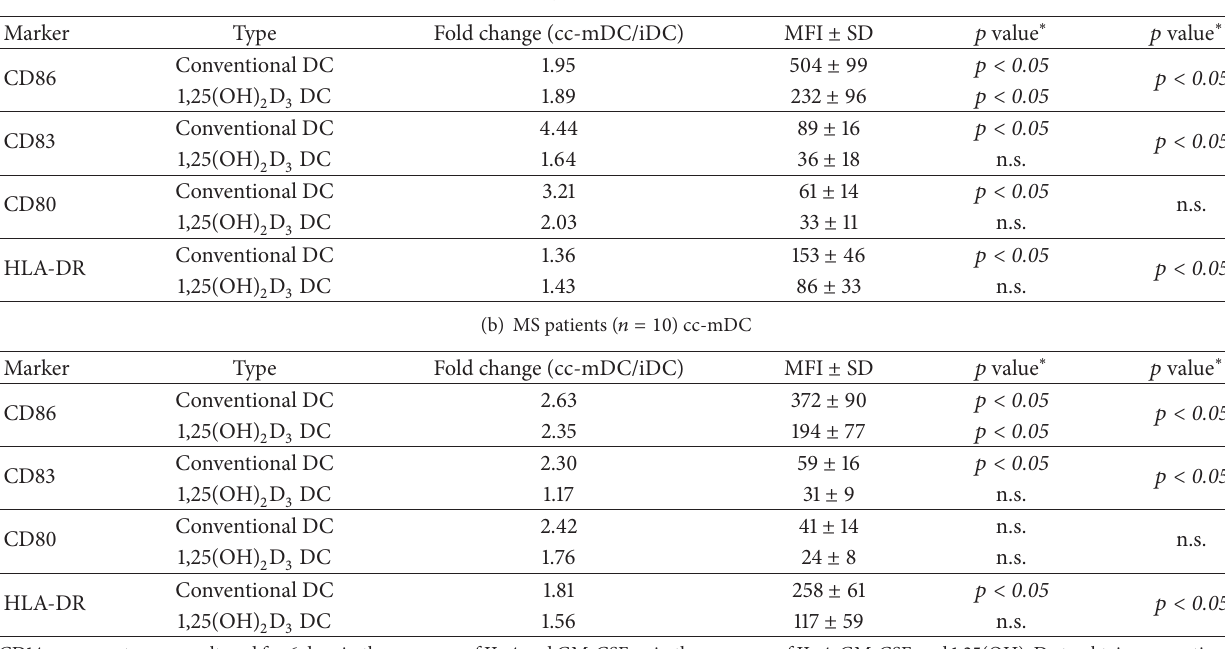
Table 2: Immunophenotypic analysis of in vitro differentiated DC from healthy controls and MS patients upon stimulation with proinflammatory